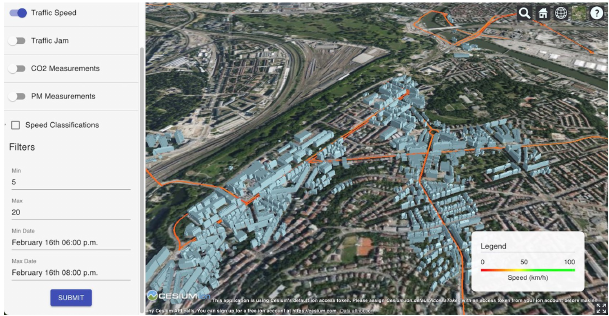
Figure 3. Filtering 2D roads with 3D buildings